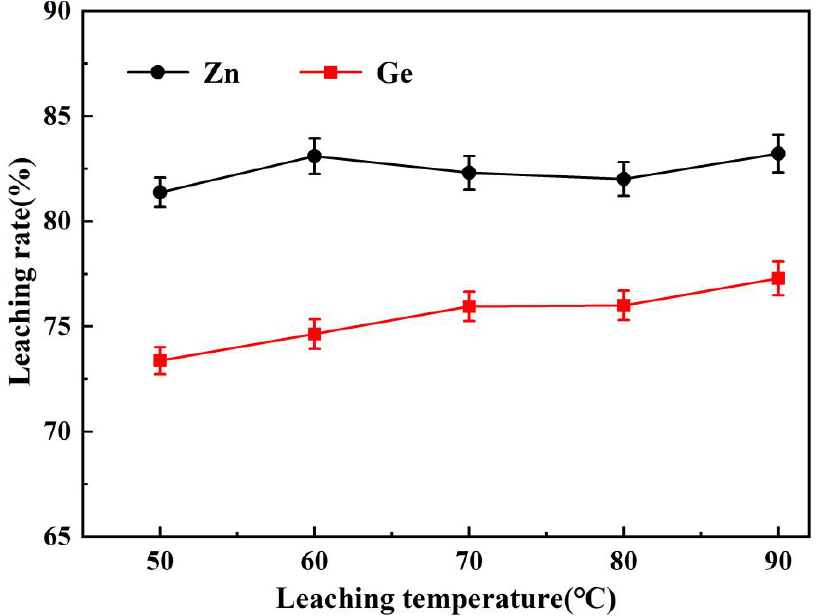
Figure 8. Effect of leaching temperature on metal leaching rate (leaching time = 60 min, initial acidity = 160 g·L −1 , L/S mass ratio = 5:1, and stirring speed = 400 r·min − 1 ).